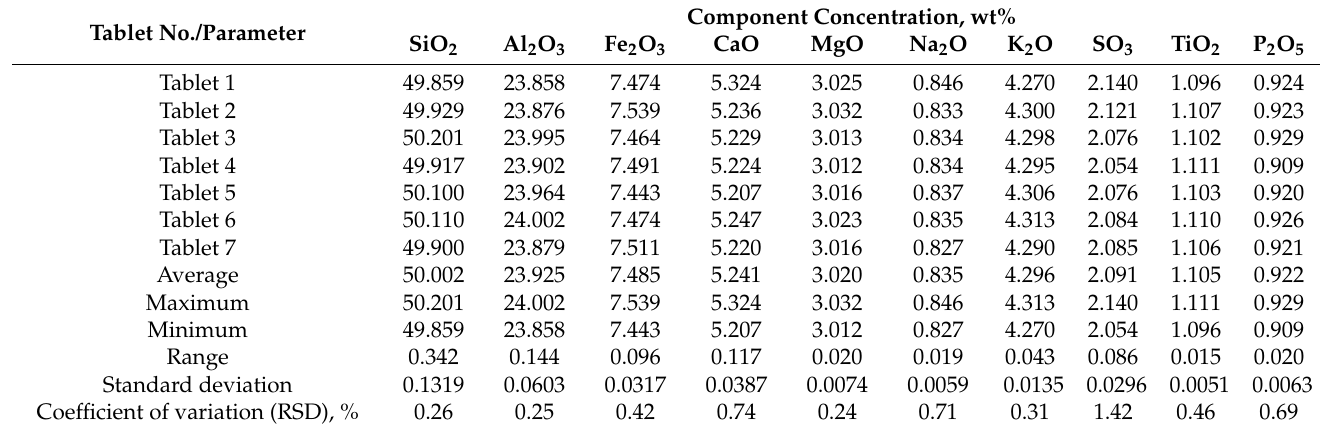
Table 3. X-ray measurement results of 7 tablets prepared from a test coal ash